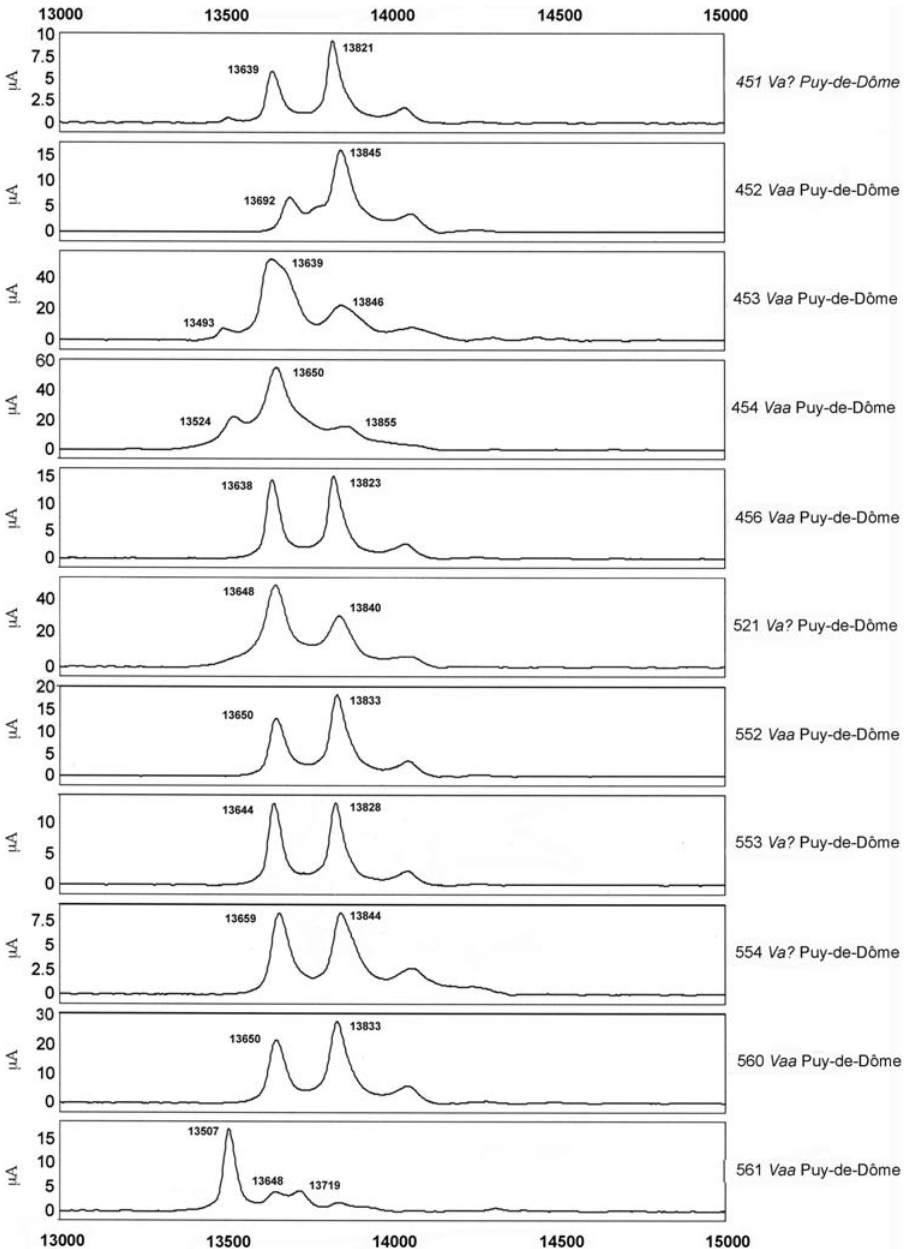
Figure 8. SELDI profiles of venoms from Puy-de-Doˆme (code no. 63). Peak molecular weights consistent with those of PLA 2 s are indicated on the